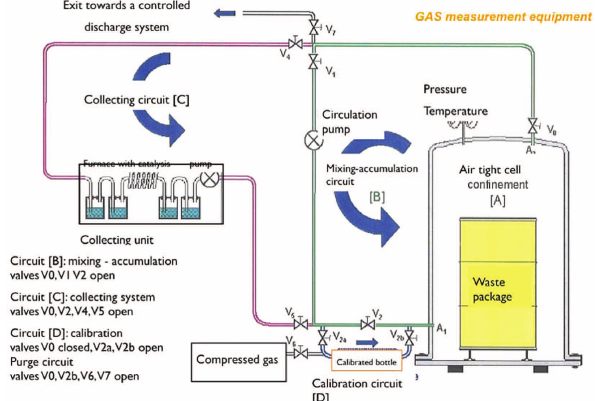
Fig. 18. Description of an accumulation measuring device.